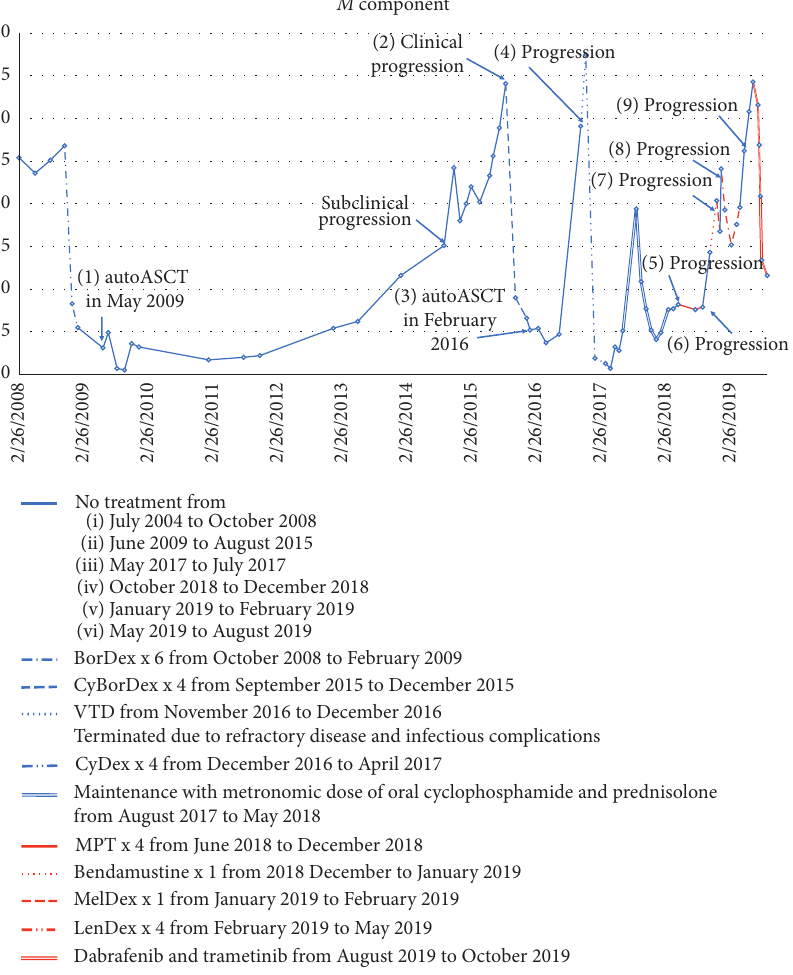
Figure 1: Treatment lines. Data on the M component are available from 2009. From 2002 to 2008, the M component could not be assessed due to laboratory limitations: (1) consolidation with autologous blood stem cell transplant (autoASCT) in May 2009 included stem cell mobilization and harvesting followed by conditioning with high-dose melphalan (Mel200mg/m2). (2)In September 2015, the clinical progression manifested with pain in the chest and spine. (3) Consolidation with autologous blood stem cell transplant in February 2016. Conditioning with high-dose melphalan (Mel200mg/m2), cryopreserved stem cells from 2009 harvest. (4) Nine months after second autoASCT, the fourth clinical progression was diagnosed based on the M component rising to 29.1g/l, kappa LC 1250mg/l. (5) During maintenance treatment, the new plasmacytoma in lumbar vertebrae occurred. This resulted in left leg paresis and spinal decompression was performed. (6) Worsening of bone pain and M component increase. (7) New skull plasmacytoma and M gradient increase. (8) New multiple skull plasmacytomas and worsening of bone pain and polyneuropathy, which led to significant decline in functional status. (9) Skull plasmacytomas regressed, but the disease response was minimal due to the stabile M component. During the first cycle, the patient experienced proximal left humerus fracture due to a trauma. Osteosynthesis was performed. Two months later, the patient was repeatedly operated due to left upper arm deformation and potential metal construction cutaneous perforation. Biopsy was taken from the left humerus fraction site. During the fourth LenDex cycle, the biopsy revealed plasmocytic